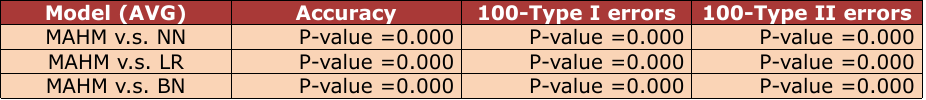
Table 12. The statistic